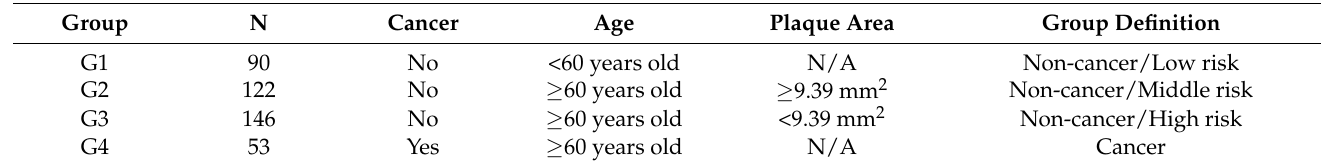
Table 3. Divided groups by age and atherosclerotic plaque area.